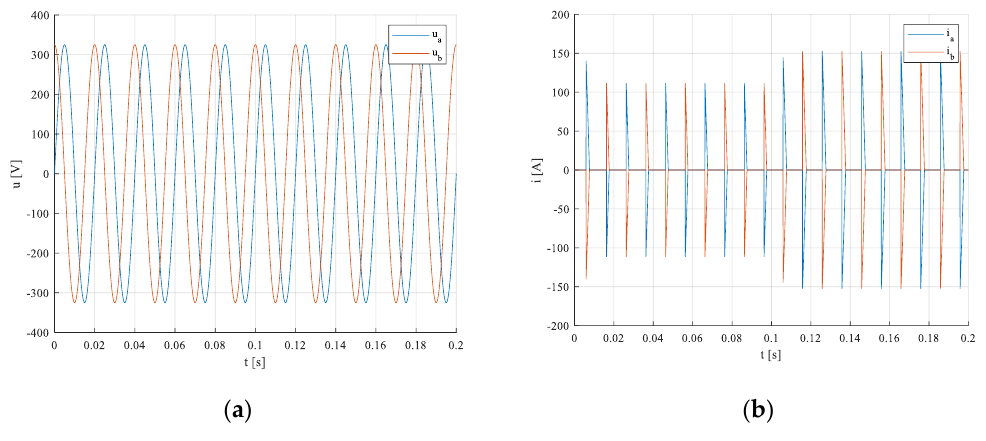
Figure 18. Phase voltages ( a ), currents in α , β ( b ) during transient. Voltage and current on the DC side under step change of resistive load are shown in Figure 19a,b.